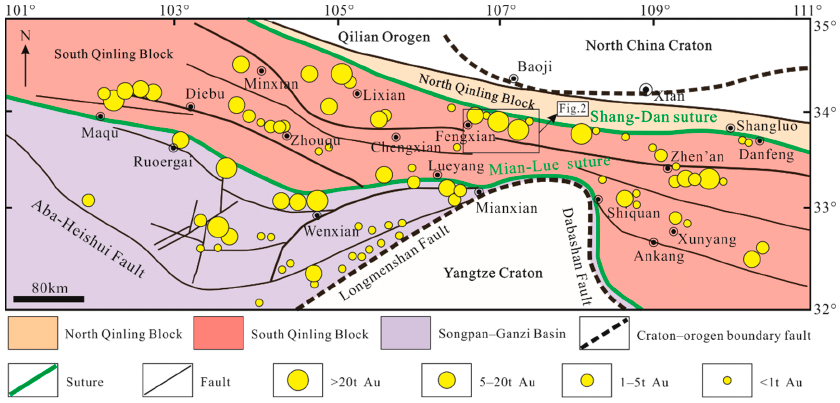
Figure 1. Simplified geological map of the western Qinling Orogen with the location of gold deposits (modified from [2,17]).